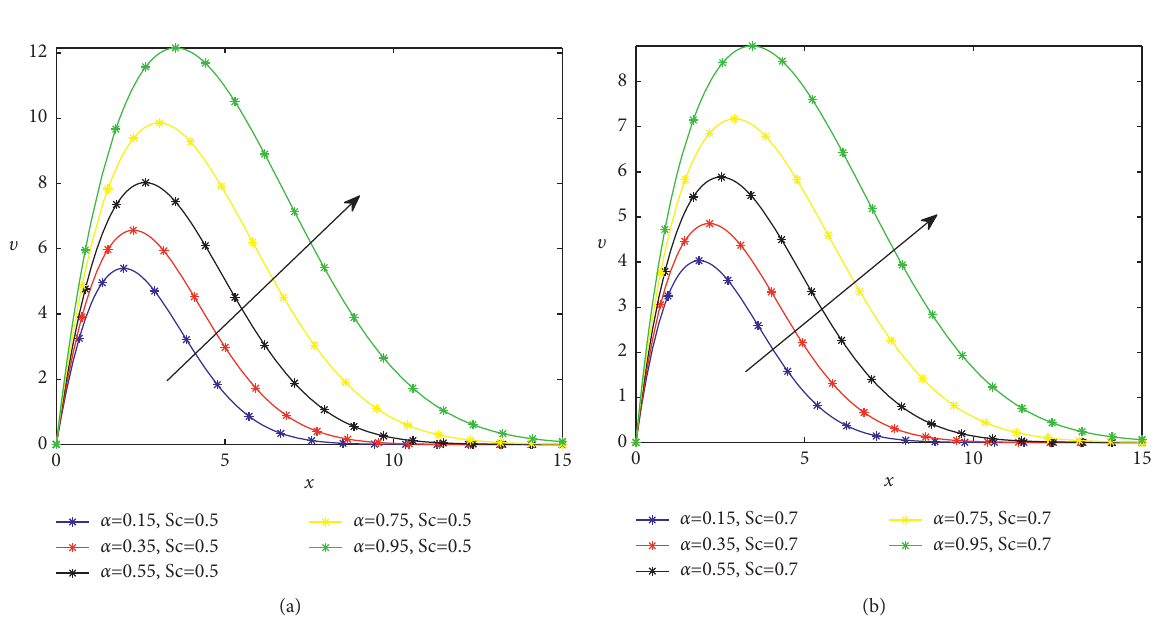
Figure 8: Velocities for different values of order α